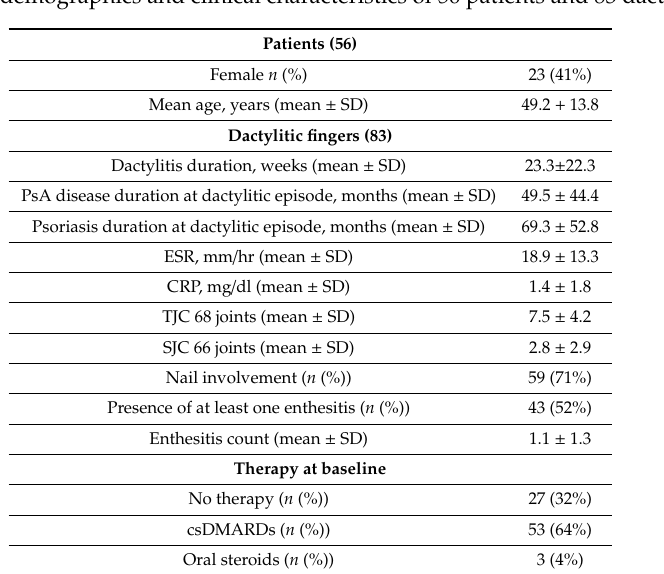
Table 1. Baseline demographics and clinical characteristics of 56 patients and 83 dactylitic